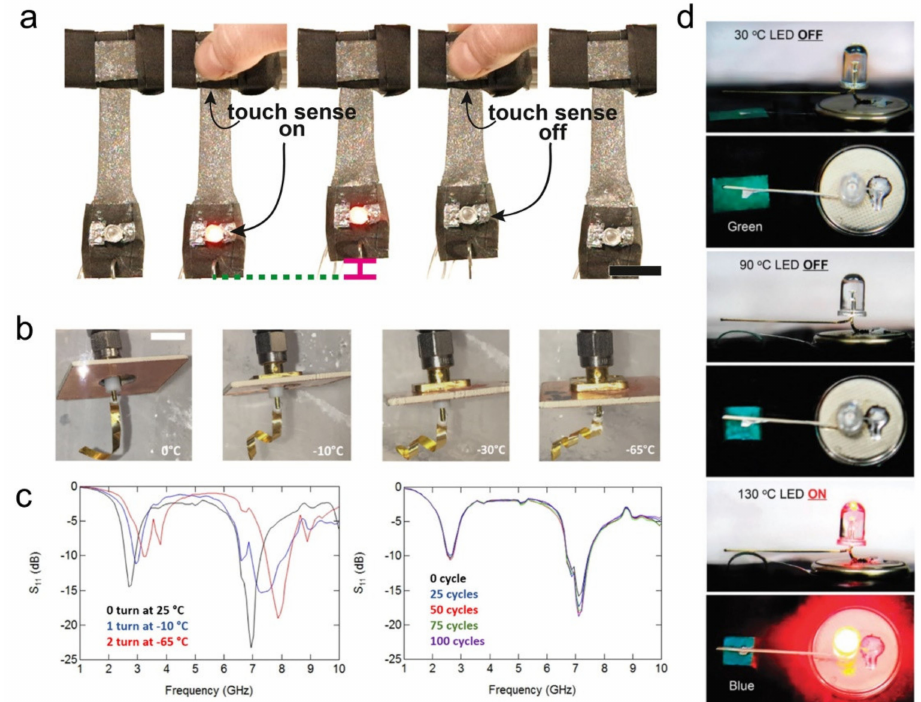
Figure 8. ( a ) LM–LCE composites function as a conductive wire to run current through an LED, as a transducer to sense touch, and as a Joule-heated actuator to lift a weight. An LED turns on when the sensing composite responds to touch, and internal Joule-heated actuation is activated [166] (Repro- duced with permission from Ford, M.J.; Ambulo, C.P.; Kent, T.A.; Markvicka, E.J.; Pan, C.; Malen, J.; Ware, T.H.; Majidi, C. A, Proc Natl Acad Sci USA; published by 2019 National Academy of Sciences.) ( b ) Photographs of LCE composite antenna shape changes at different temperatures. ( c ) Measured reflection coefficient of the LCE antenna as temperature decreases(left); and measured frequency response of the reflection coefficient from 0 to 100 cycles(right) [39] (Adapted with permission from Kim, H.; Gibson, J.; Maeng, J.; Saed, M.O.; Pimentel, K.; Rihani, R.T.; Pancrazio, J.J.;